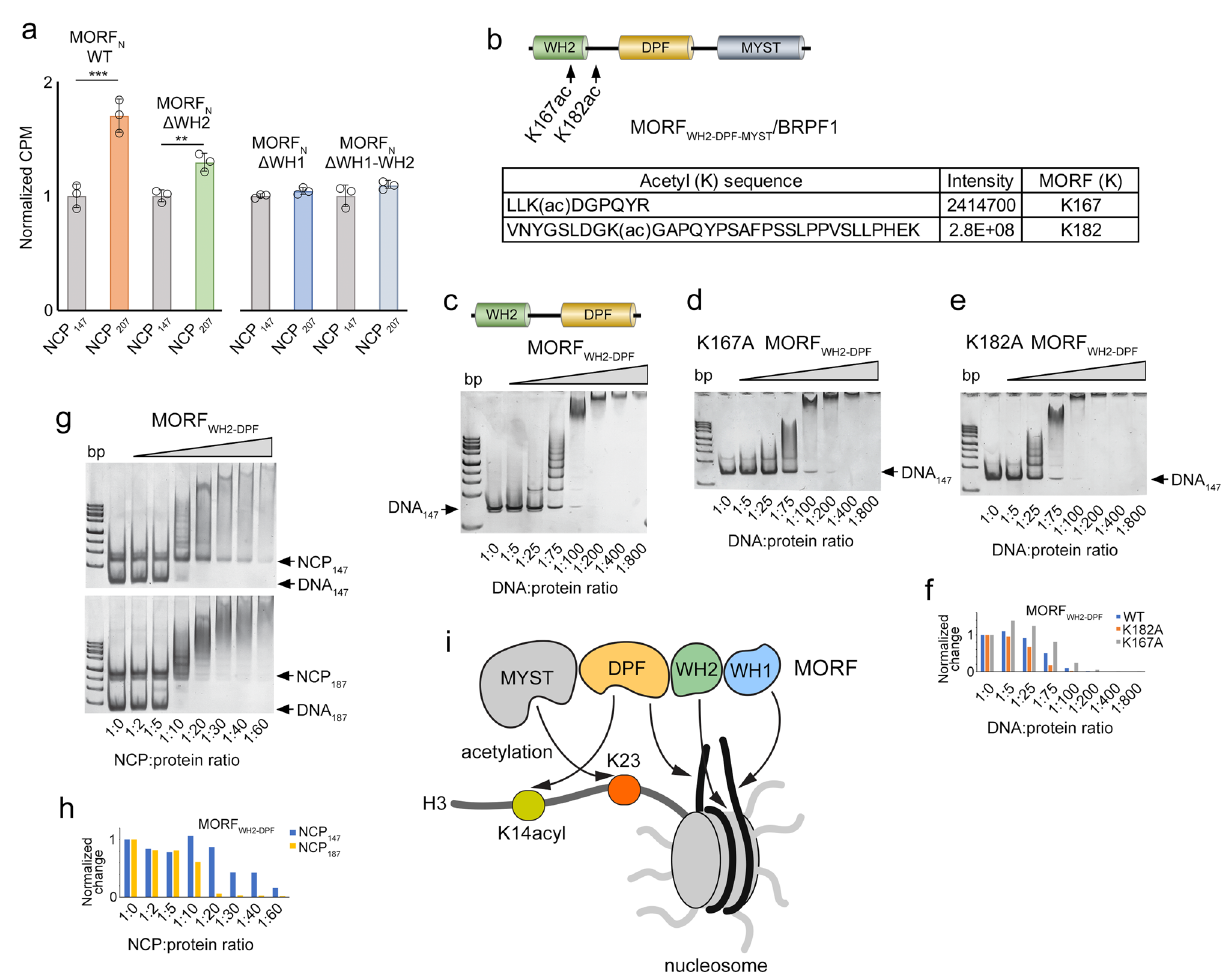
Fig. 9 | Impact of auto-acetylation and the DNA linker on the HAT activity and binding to DNA. a In vitro liquid HAT assays show acetyltransferase activity of nativeWTandmutatedMORF N complexes,puri fi edfromK562cellsonNCP 207 and NCP 147 . Values for NCP 207 are normalized to the corresponding values for NCP 147 . Data represent mean±SEM from three independent experiments. n=3 Statistical tests were two-sided. Student ’ s t ‐ test, *** P <0.005, 0.005<** P <0.01